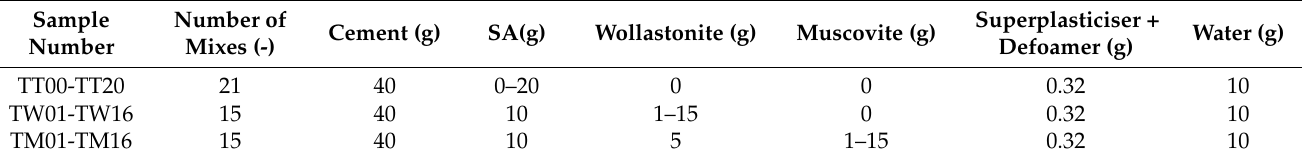
Table 1. Initial mixes with cement and SA emulsion (mass in each